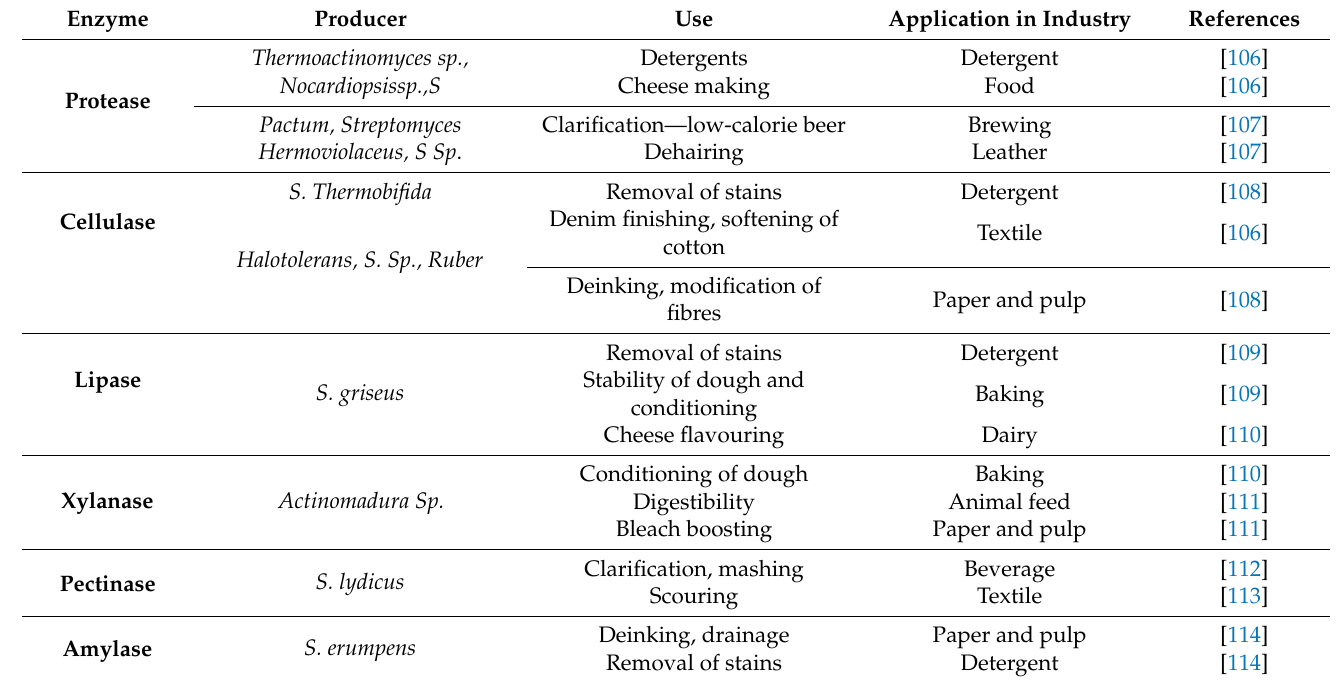
Table 5. List of enzymes, their producers, uses and application in industry isolated from